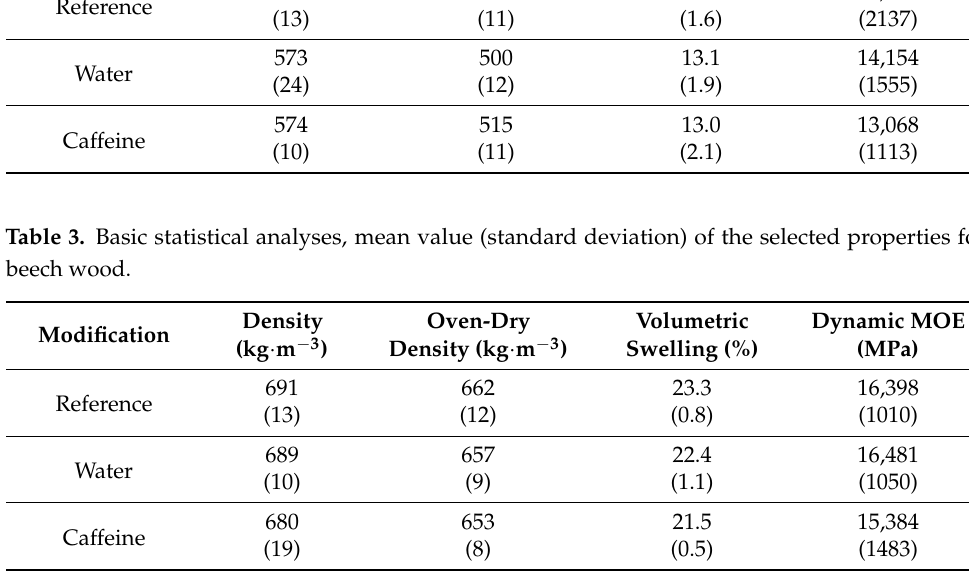
Table 4. Concentrations of caffeine (mg of caffeine/g of wood) in 3 layers of caffeine treated spruce, pine and beech samples. Concentration of Caffeine